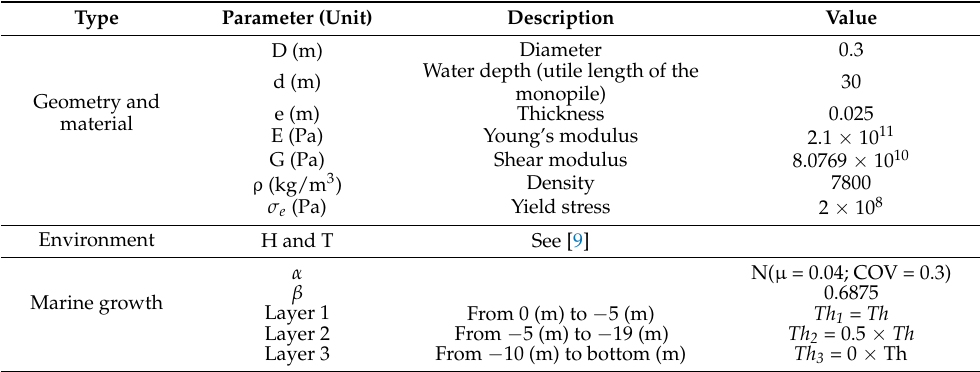
Figure 5. Proposed flowchart for loading computation in the presence of marine growth (adapted from [9]). Table 2. Input parameters and random